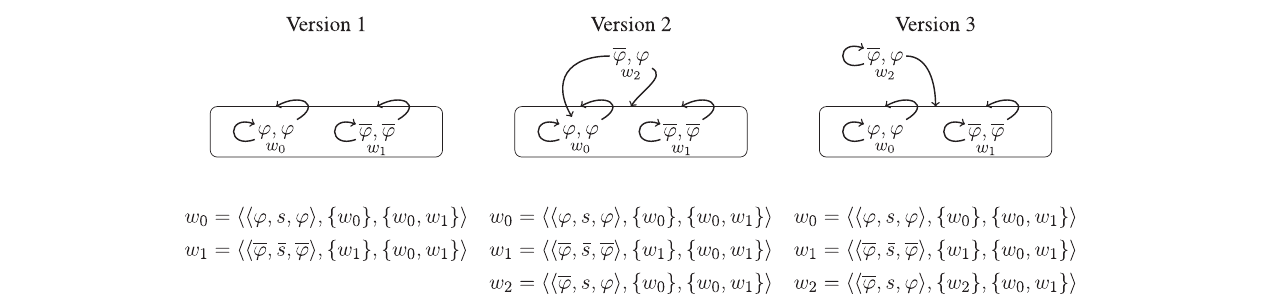
TABLE 5 | Worlds and their epistemic graphs for scenarios in